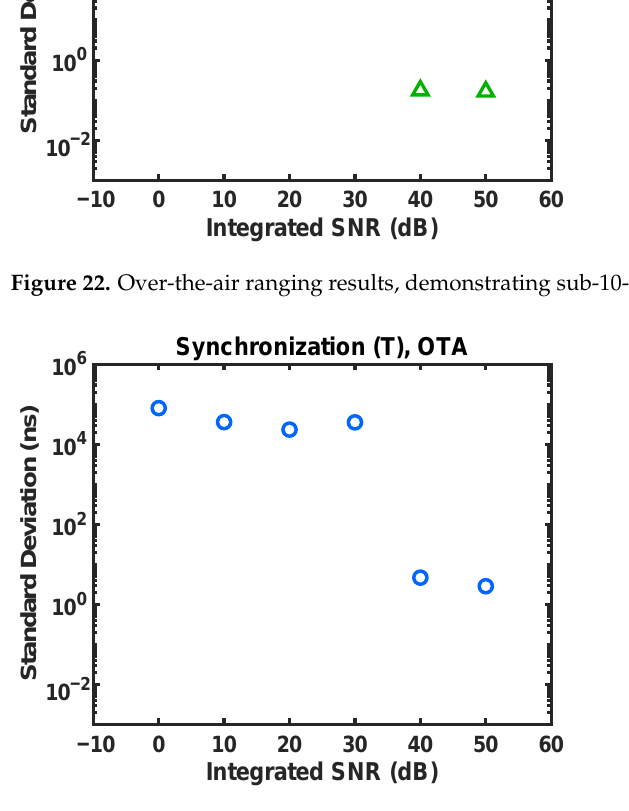
Figure 23. Over-the-air synchronization results, demonstrating sub-ns